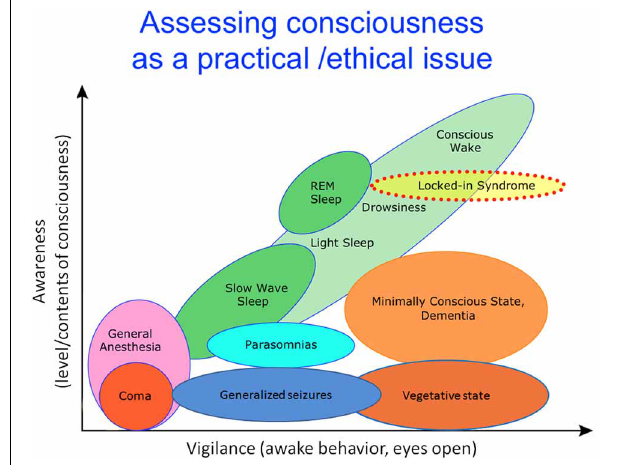
FIGURE 1 | Level and contents of consciousness. The level of consciousness can be dissociated from behaviors that are traditionally regarded as a signs of vigilance or arousal (such as opening of eyes, command following etc.). Typically, high conscious levels are associated with an increased range of conscious contents. Whether or not high level of consciousness without any conscious contents is possible remains unclear. Adapted from Laureys (2005), courtesy of Giulio